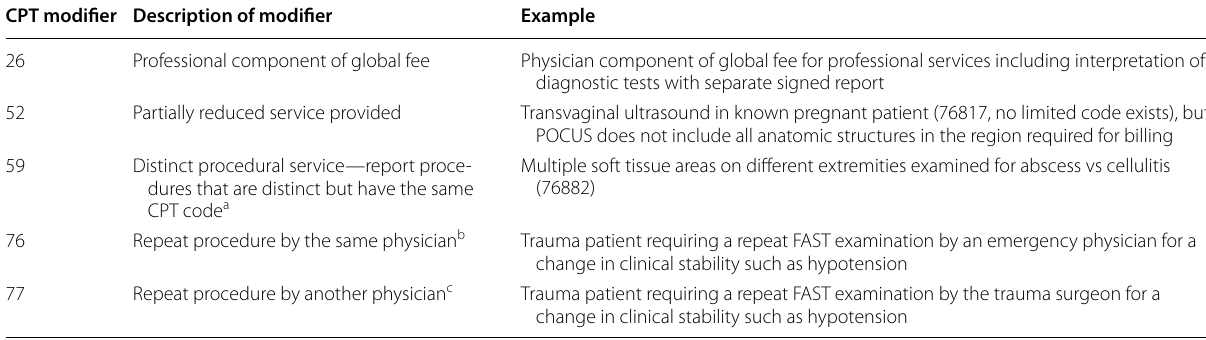
Table 2 Common CPT modifier codes, to be added after the five-digit CPT code (see Table